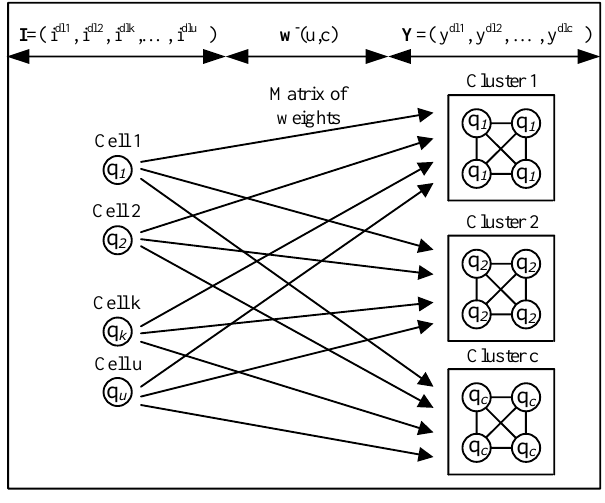
Figure 4. Deep Learning Cluster.